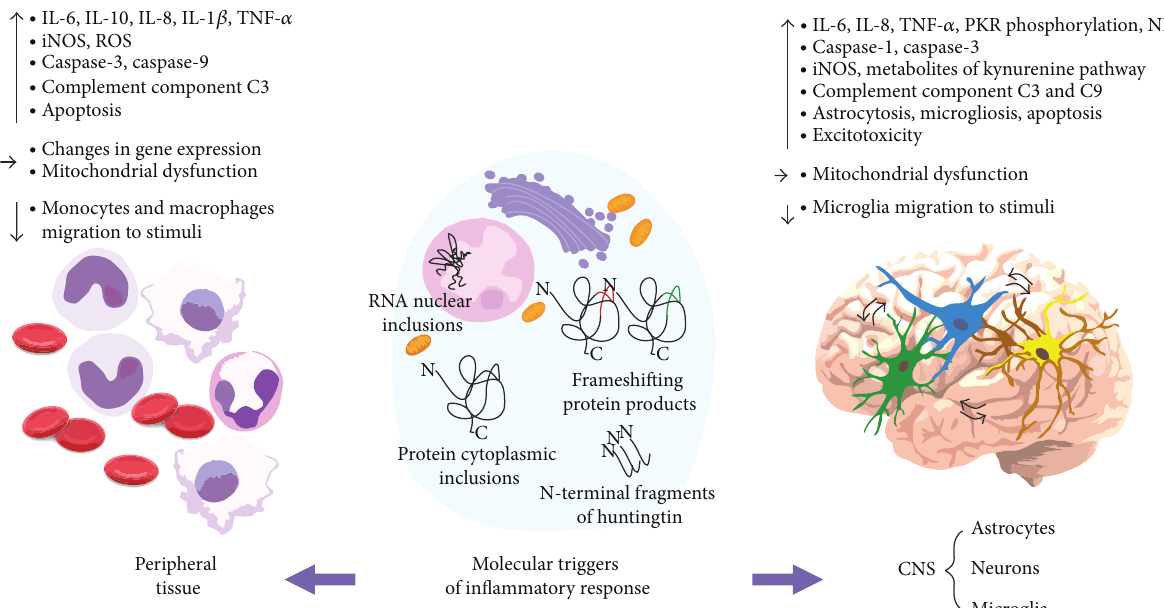
Figure 1: Inflammation in Huntington’s disease. The mutant HTT transcript and protein are expressed in many cell types, including neurons, astrocytes, and blood cells of HD patients. The pathogenic effect may be triggered by expanded CAG repeat hairpins, cytoplasmic protein aggregates, N-terminal fragments of huntingtin, or toxic frameshifting products, and so forth. It is currently not clear what pathways are primarily involved in inducing the inflammatory response observed in the CNS and peripheral immune system. This effect is observed in the brain and peripheral tissues, indicating crosstalk in the signaling between distant tissues. The observed immune effects include elevated cytokine levels, caspase pathways activation, induction of apoptosis, dysregulation of gene expression, or decreased immune cell